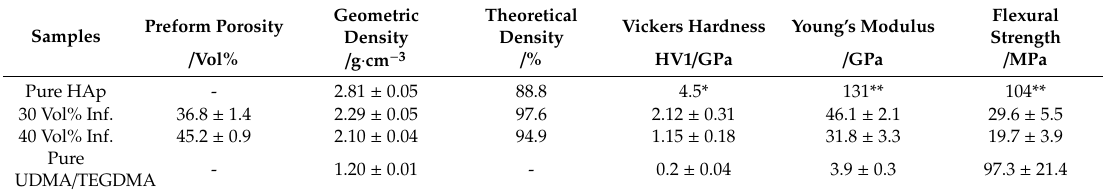
Table 2. Microstructural and mechanical properties of the interpenetrating HAp / UDMA composites and pure reference